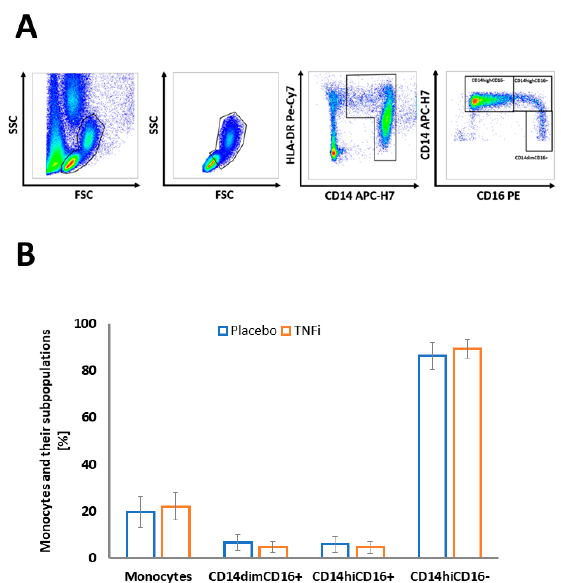
Figure 1. ( A ) Gating strategy of monocyte subpopulation in circulating blood. ( B ) Mean monocyte content and their subpopulation distribution at baseline (t0) in placebo and the anti-TNF- α treated group (TNFi). Error bars represent SD. Int. J. Mol. Sci. 2019 , 20 FOR PEER REVIEW